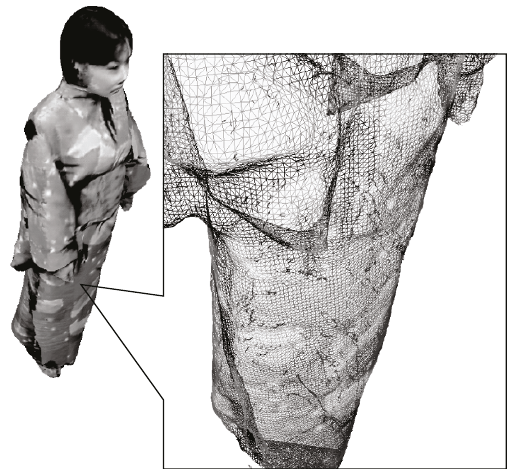
Figure 2: Example frame of our TVM data. Each frame is described in a VRML format and consists of coordinates of vertices, their connection, and